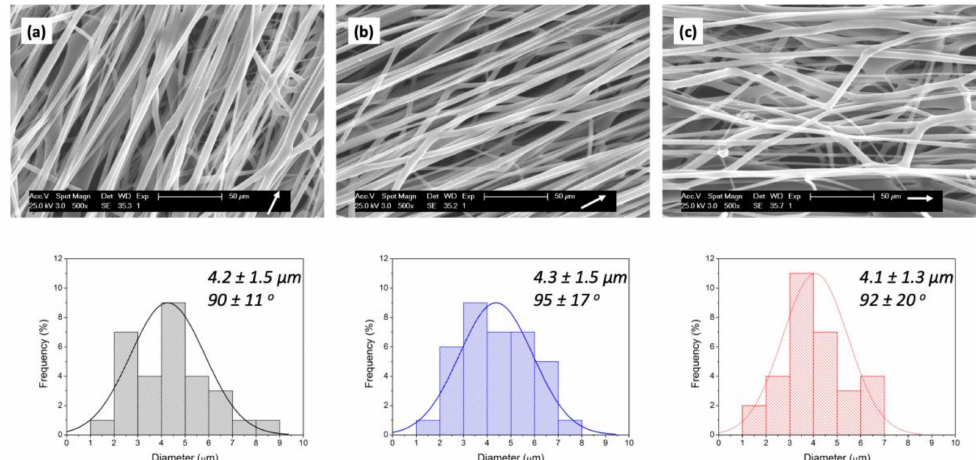
Figure 3. SEM images of the electrospun fibers and the corresponding size histograms and orienta- tions of ( a ) PLA, ( b ) PLA/PMS, and ( c ) PLA/PMSAc. (White arrows indicate the orientation of the rotatory collector).